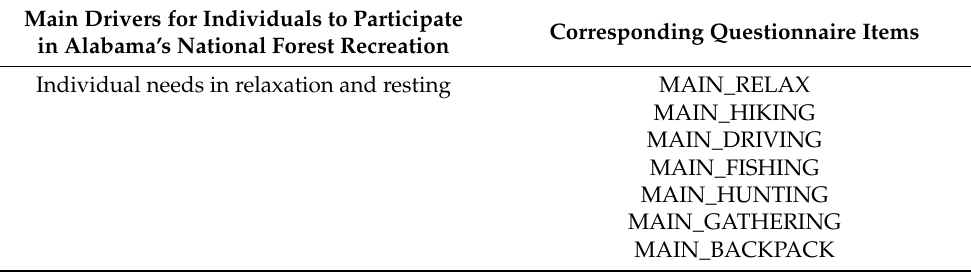
Table 2. Relationships between main drivers for individuals to participate in Alabama’s National Forest Recreation and corresponding questionnaire